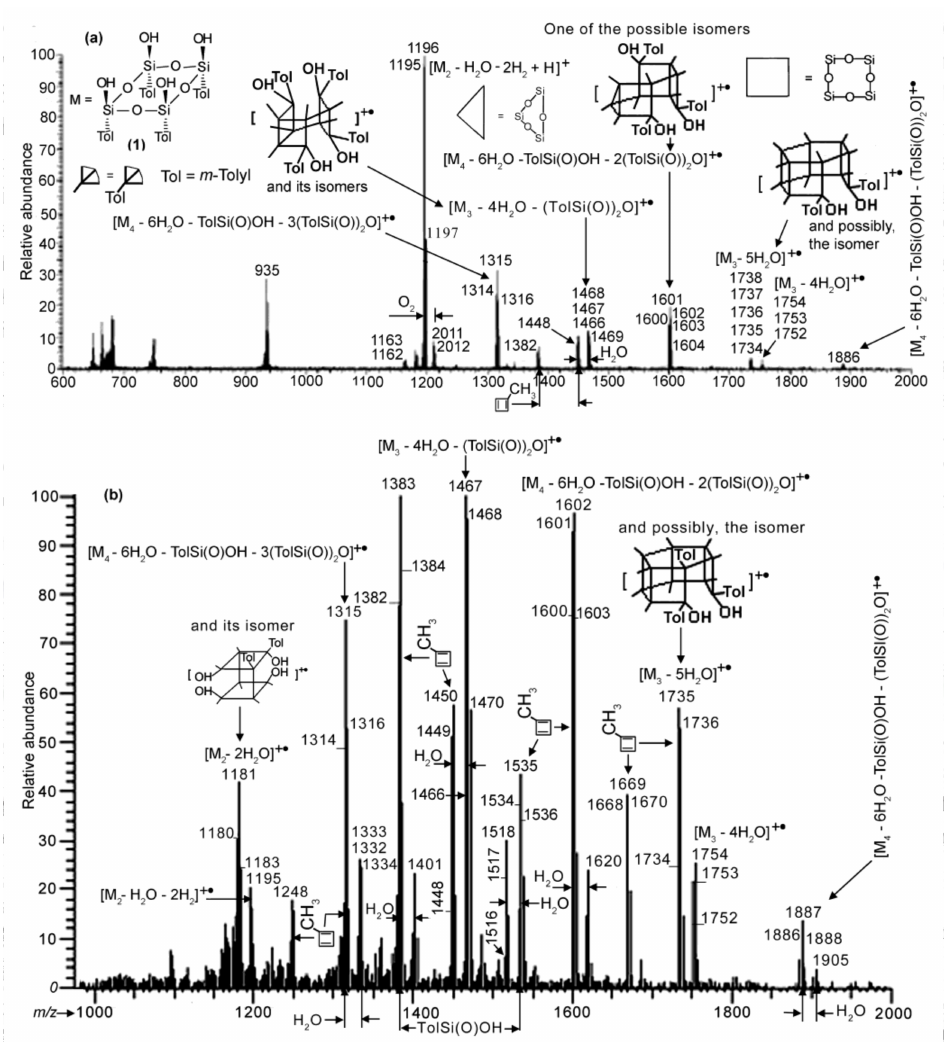
Figure 4. Positive ion mode atmospheric pressure chemical ionization (PI APCI) mass spectra of the products obtained after heating of a toluene solution of 1 at atmospheric pressure at 110 ◦ C: ( a ) in a quartz flask for 130 min (product 3.2 ) and ( b ) in a molybdenum glass flask for 120 min (product 3.1 ); the schemes at the peaks mostly give the routes of the formation of the corresponding compounds rather than fragmentation paths in the mass spectrometer. However, some contributions from the fragmentation processes are possibly present in ions, these fragmentations probably occurring as ‘in-source collision-induced dissociation’ [28,29] (also, see Note 2 in the Supplementary Materials